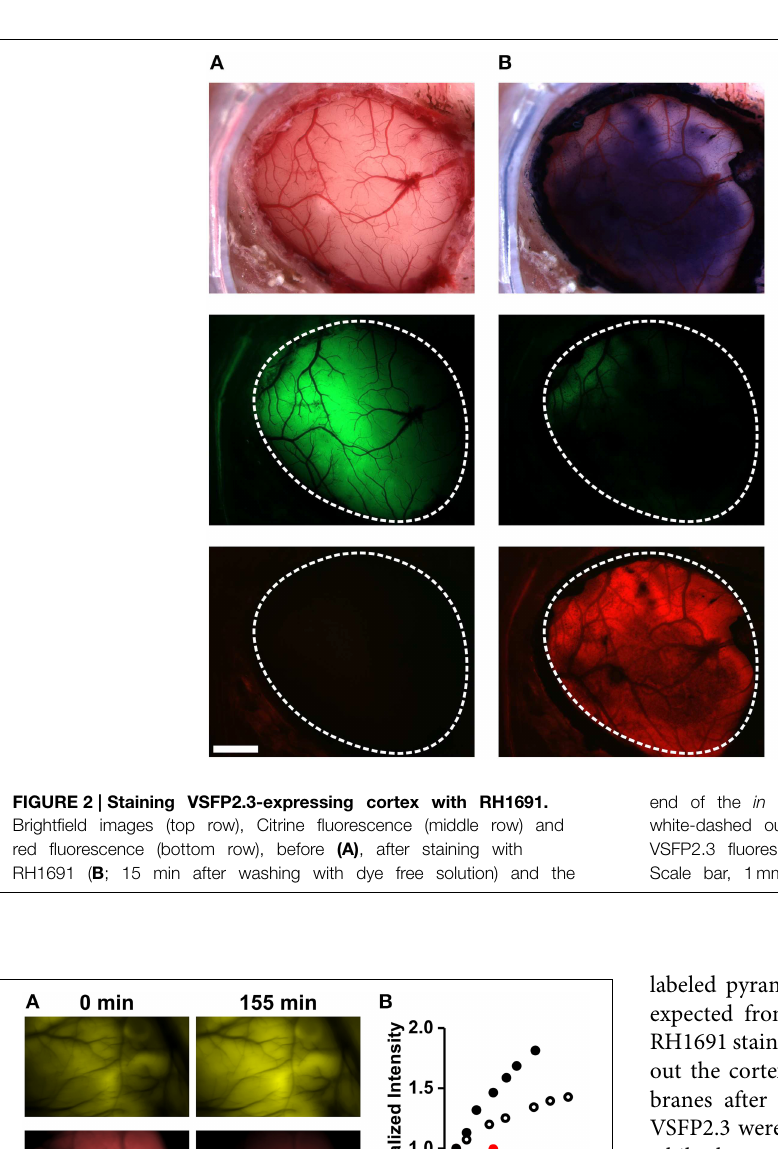
FIGURE 3 | Destaining of RH1691 and recovery of VSFP2.3 fluorescence. (A) VSFP2.3 Citrine fluorescence (top row) and RH1691 red fluorescence (bottom row) images taken immediately (left column) and 155 min (right column) after washing off the staining solution. Scale bar, 1mm. (B) Time course of normalized fluorescence intensities (red symbols; RH1691, black symbols; Citrine fluorescence of VSFP2.3; open and closed symbols are from two different animals). (C) VSFP2.3 signal ( 1 R/R, black) and RH1691 signal ( 1 F/F, red) measured at times indicated in (A)